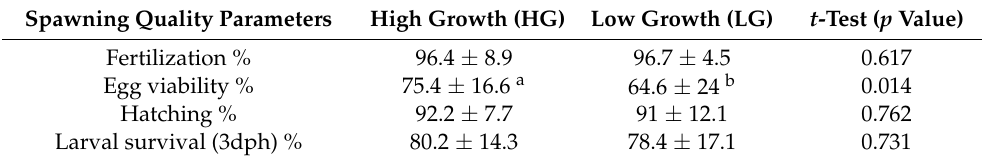
Table 6. Relative spawning quality (%) in gilthead seabream broodstock selected for high (HG) or low (LG) growth before experimental diet feeding period (HG, n = 56; LG, n =